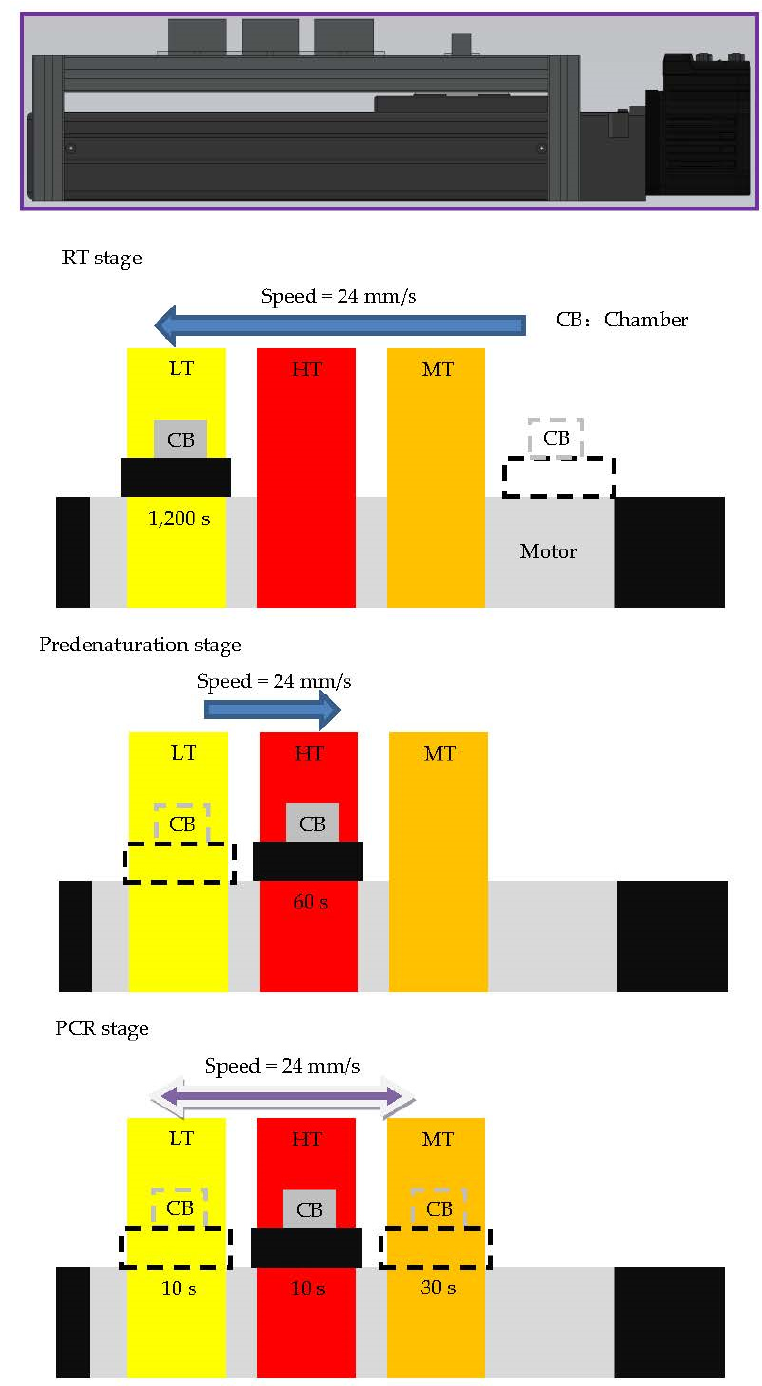
Figure 8. The physical configuration of the oscillating thermocycler. Three stages including RT, predenaturation, and PCR stages, are